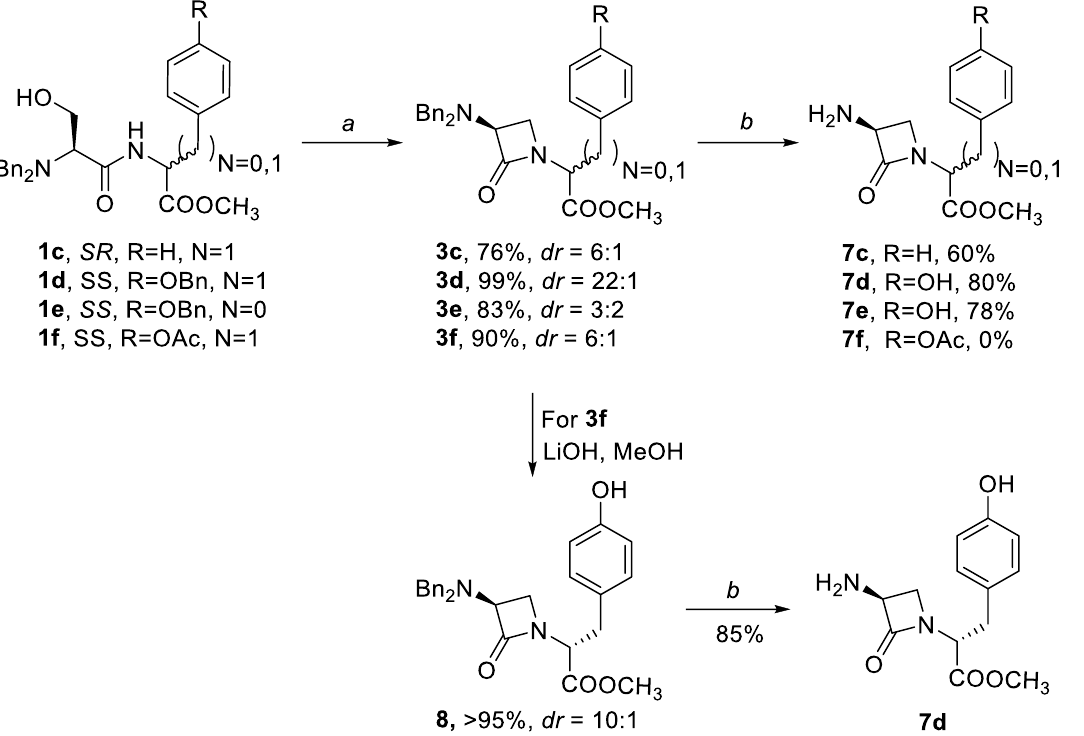
Scheme 3. Formation of β-lactam pseudopeptides and their deprotection. Conditions: (a) DIAD, PPh 3 , THF or DMF; (b) H 2 -Pd/C, 5%